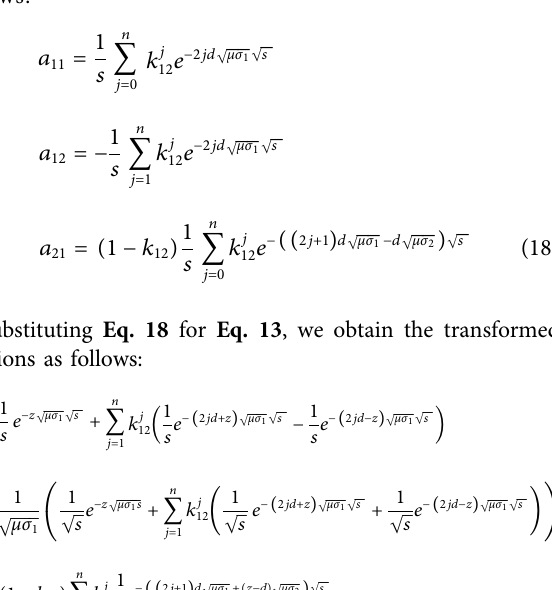
magnetic fi eld B y perpendicular to the propagation plane and the ionospheric and ground surface currents with north-south direction (Kikuchi and Araki, 1979). The good correlation between the GIC and B y may indicate that the GIC is the ground surface current transported by the TM 0 mode waves as suggested by Watari et al. (2009) and Brändlein et al. (2012). Figure 1 also shows the IEF in one-layer model, E x I and E yI induced by B y and B x , respectively (top right), and the IEF in the two-layer model, E x II and E y II (bottom right). The correlation coef fi cient of the GIC with E x I is cc ( GIC − E x I ) (cid:1) 0 . 77, less than cc ( GIC − B y ) (cid:1) 0 . 90, but the correlation with E x II